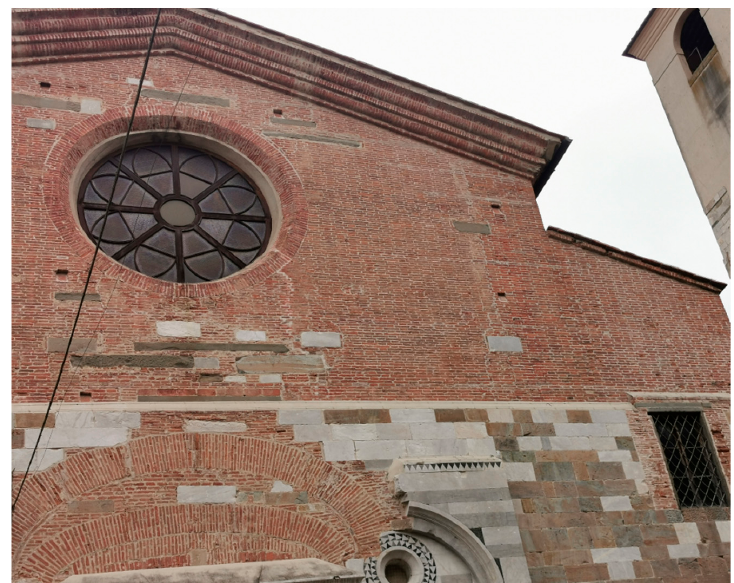
Figure 26. The actual aspect of the main façade—detail (June 2021).